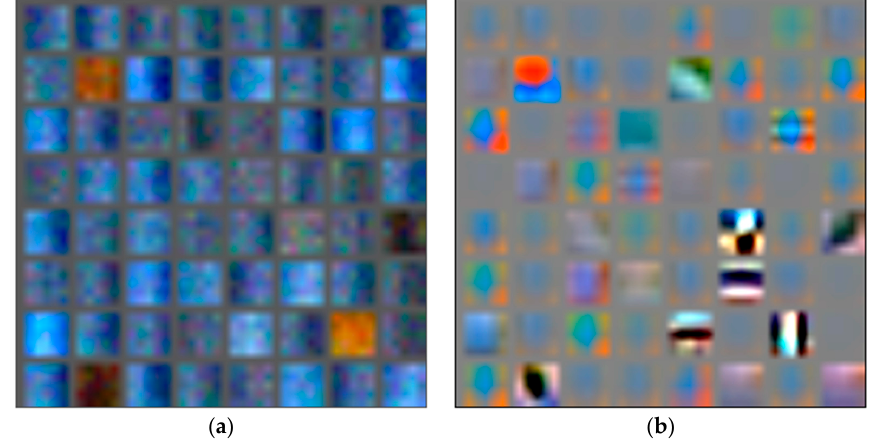
Figure 4. ( a ) Visualization of the first layer at the beginning of the training; and ( b ) visualization of the first layer at the end of the training.